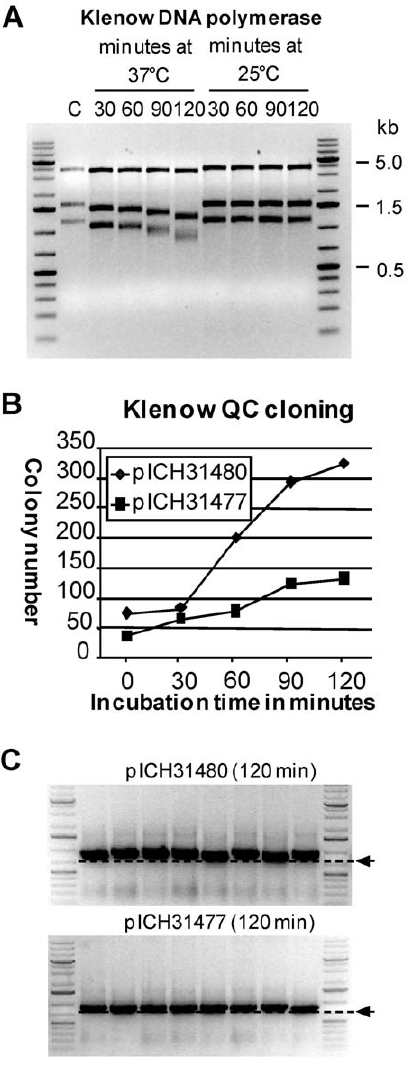
Figure 9. Test of QC cloning using Klenow DNA polymerase. (A) Test of Klenow exonuclease activity determined using the same assay used for T4 DNA polymerase. (B) To test QC cloning using Klenow DNA polymerase, the PCR product T019 GC3F was cloned into pICH31477 (23 nucleotide catching sequence) and pICH31480 (52 nucleotide catching sequence). Incubation was performed at 37 u C for 0, 30, 60, 90, and 120 minutes. ( C ) Eight randomly chosen clones from 120 min time points were analyzed by colony PCR using vector primers. The size of the expected full-length fragment is indicated by an arrow.